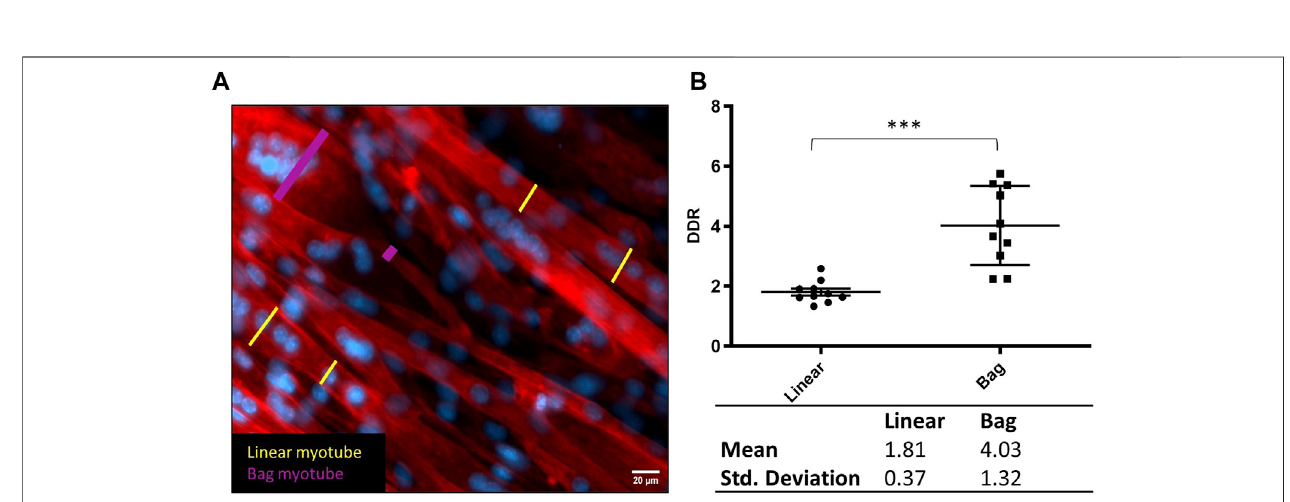
FIGURE 2 | De fi ning bag and linear myotubes using Diameter Difference Ratio (DDR). (A) Representative fl uorescent image with diameter measurements from linear myotubes in yellow and bag myotubes in pink. Phalloidin (red) DAPI (blue) (scale bar, 20 µm). (B) Scatter dot plot comparing DDR in Linear and Bag myotubes. Table below displays the mean and standard deviation from the graph which were used to determine the range for myotube populations. Mean ± SEM, n (cid:1) 10, *** p <